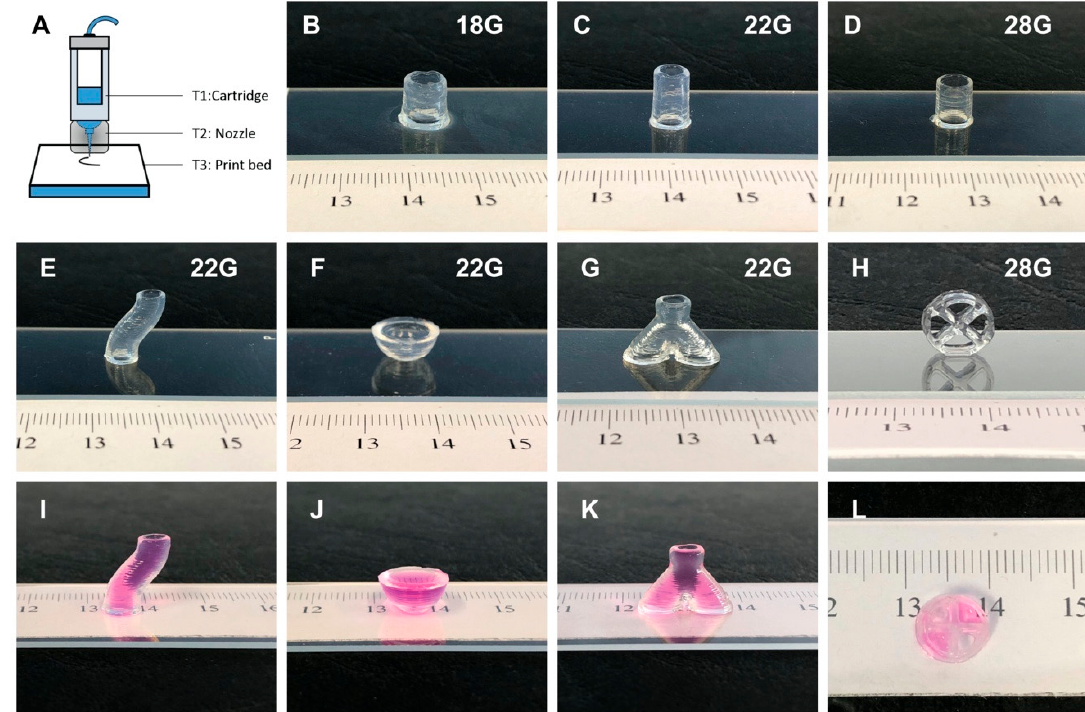
Figure 2. ( A ) Schematic of in-house-modified Cellink Inkredible-2 3D printer. T1, T2, and T3 represent the temperatures of bioink cartridge, nozzle, and print bed respectively. ( B – D ) show the constructs printed using 18G, 22G, and 28G nozzles, respectively. ( E – H ) show structures (s-shape cylinder, hemisphere, a bifurcated tube, and a cylinder with compartments) with various degrees of curvature and complexity printed using the CANA bioink system, and ( I – L ) show the same structures filled with cell culture media demonstrating the structural integrity of the printed structures.